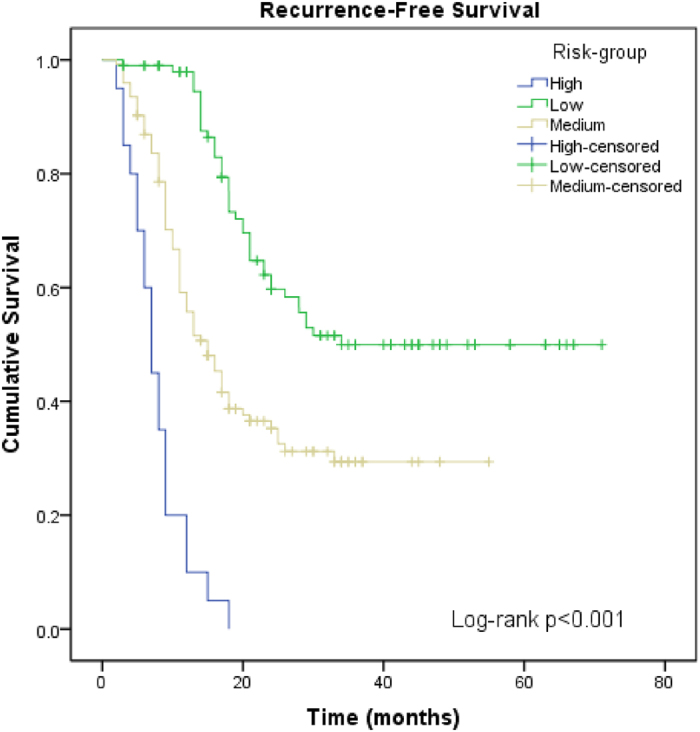
Kaplan-Meier analysis of the recurrence-free survival of NMIBC patients, stratified by risk group.Significance was determined for the comparisons of all group-pair combinations.